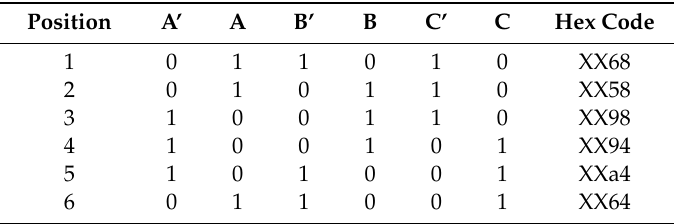
Figure 32. SVPWM analogy. Table 5. Space Vector Pulse Width Modulation (SVPWM) signal